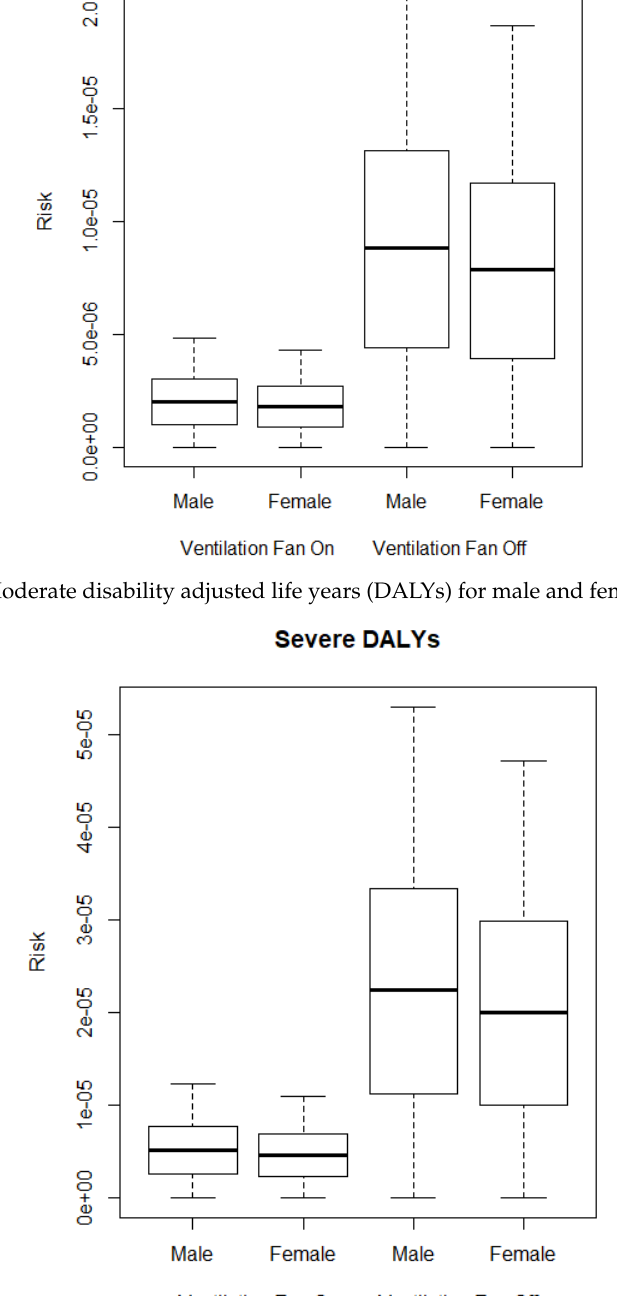
Figure 4. Severe DALYs for male and female miners.